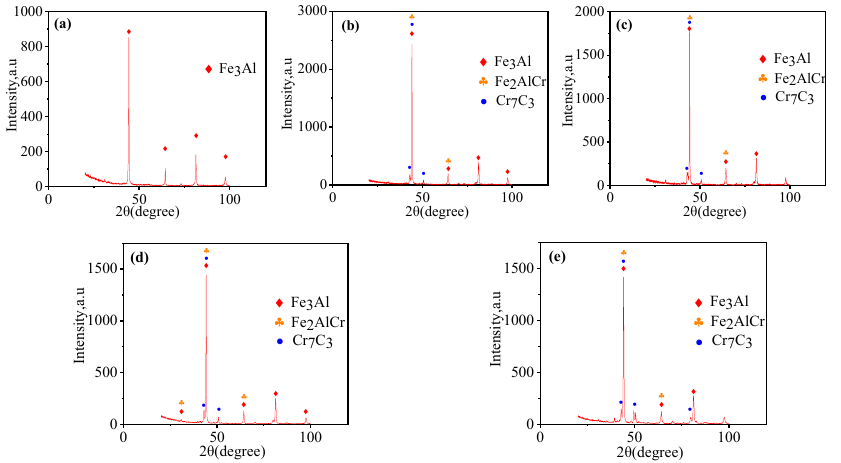
Figure 3. XRD spectra of cladding layers prepared using the same process and different Cr 3 C 2 con- tent: ( a ) 0 wt.%, ( b ) 5 wt.%, ( c ) 15 wt.%, ( d ) 25 wt.%, and ( e ) 35 wt.%.